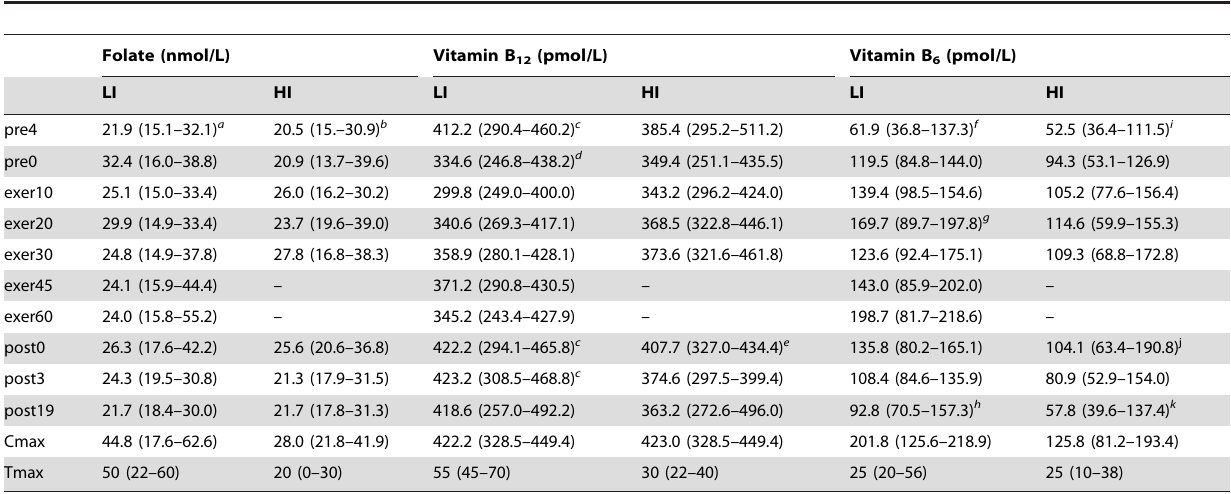
Table 2. Serum folate, vitamin B 12 , and vitamin B 6 concentration before, during, and after two acute isocaloric exercise trials at low and high intensity (LI, 40% VO 2peak and HI, 80% VO 2peak ) in sedentary volunteers (n= 8).